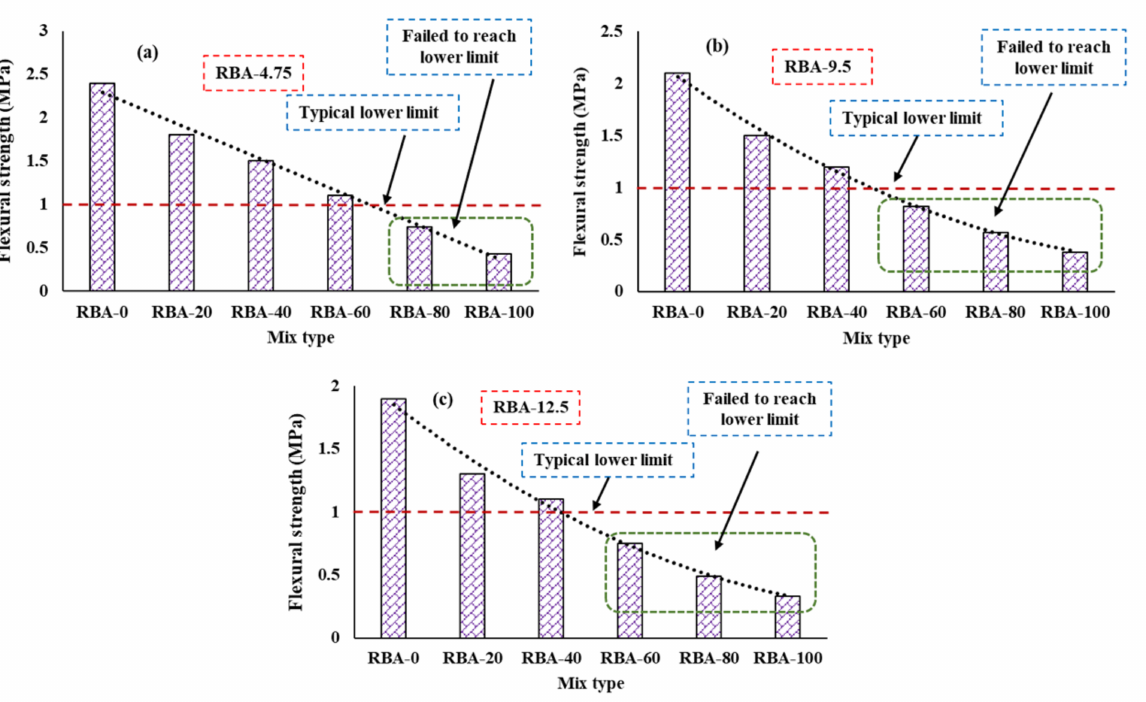
Figure 5. Flexural behavior of PC, ( a ) for RBA-4.75, ( b ) RBA-9.5, ( c )